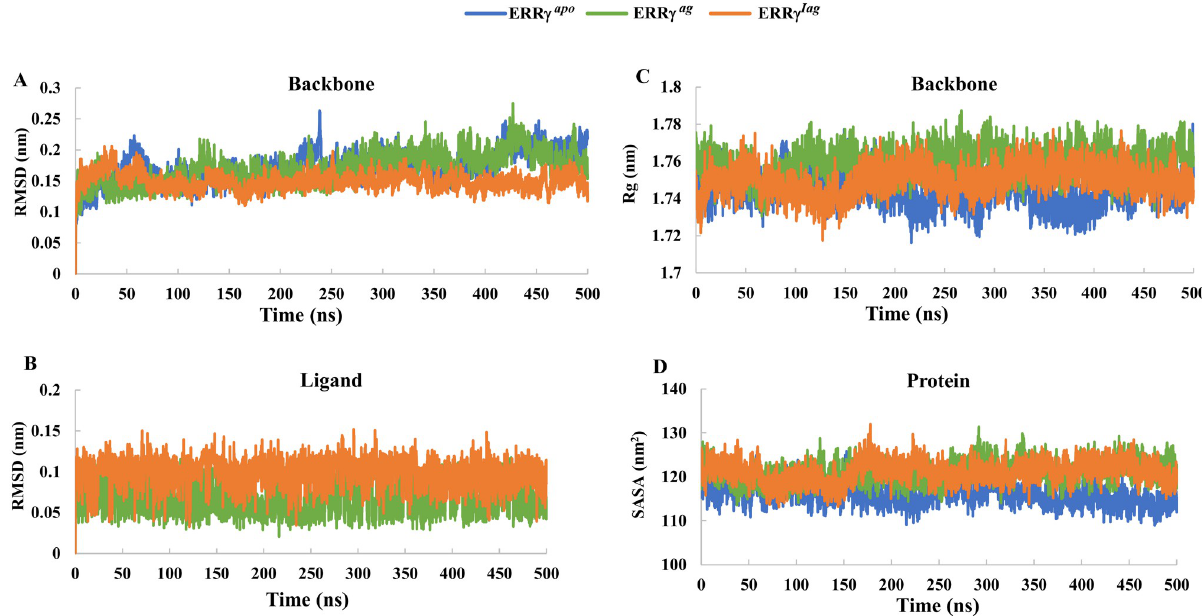
Fig 2. Trajectory analysis of ERR γ apo , ERR γ ag and ERR γ iag : (A) RMSD of ERR γ apo , ERR γ ag and ERR γ iag backbone atoms. (B) RMSD of agonist and inverse agonist (C) Radius of gyration (Rg) of ERR γ apo , ERR γ ag and ERR γ iag backbone atoms (D) Solvent accessible surface area (SASA) of ERR γ apo , ERR γ ag and ERR γ iag .